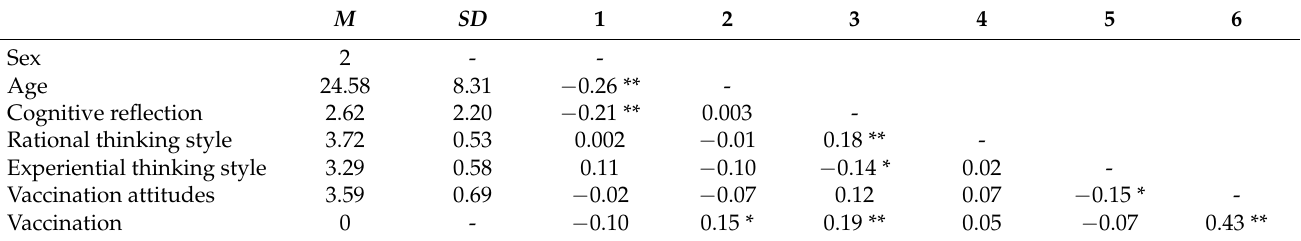
Table 1. Descriptive statistics and Pearson correlations among the studied variables.